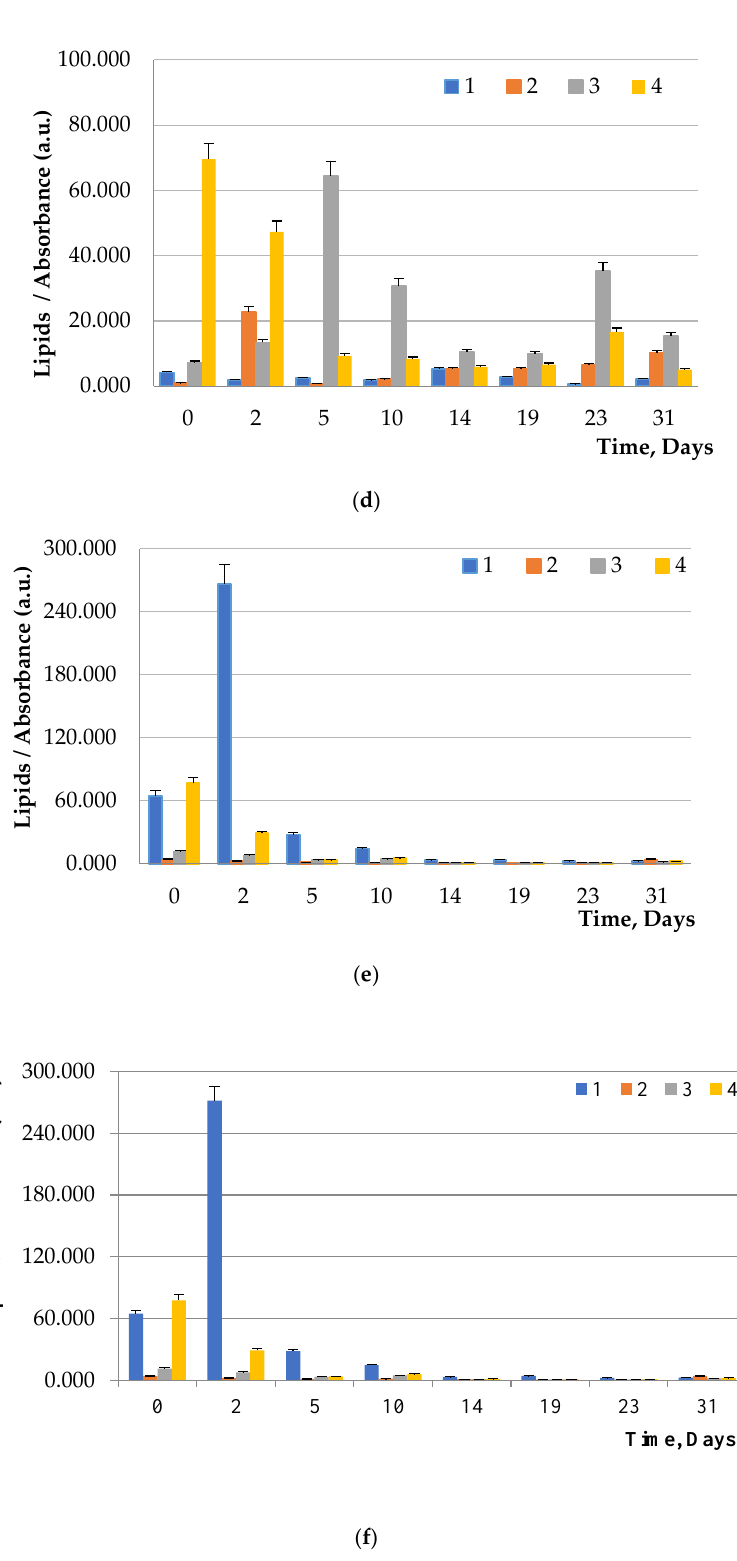
Figure 3. Influence of carbohydrates supplementation in culture media on lipid accumulation by ( a ) Chlorella vulgaris C-11, ( b ) Chlorella vulgaris C-38, ( c ) Chlorella vulgaris C-66, ( d ) Dunaliella salina , ( e ) Arthrospira platensis B-256 and ( f ) Arthrospira platensis B-287: 1—control; 2—glucose;